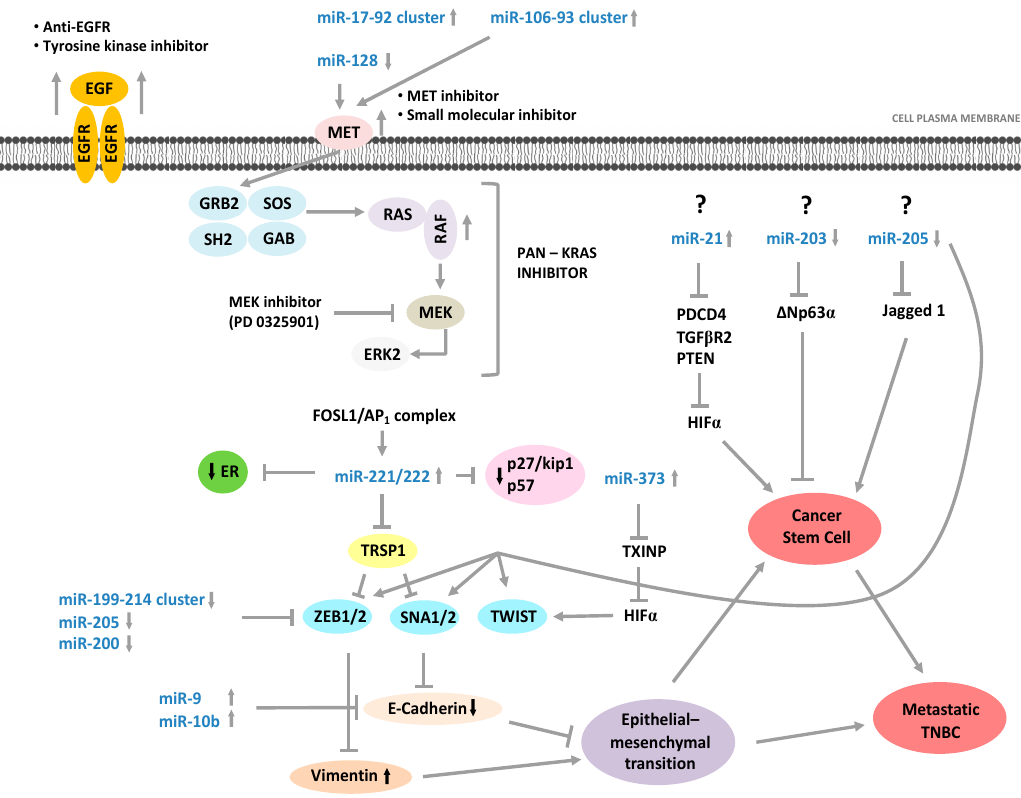
Figure 3. miRNAs / mRNA complex network in TNBC with basal-like phenotype and potential sites of Figure 3. miRNAs/mRNA complex network in TNBC with basal-like phenotype and potential sites therapeutic of therapeutic interventions.